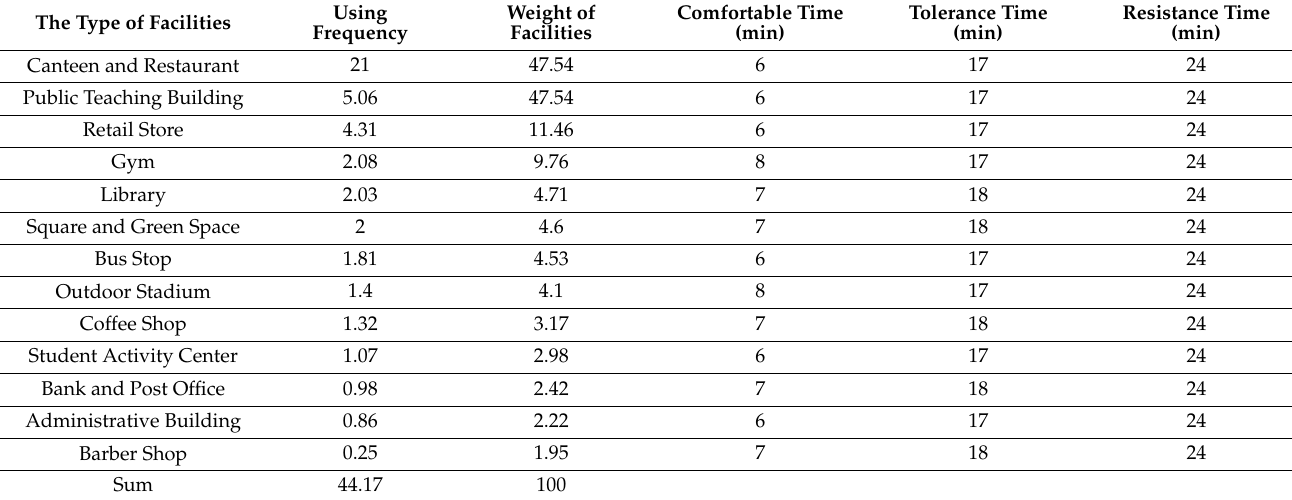
Table 2. The weight and curve of time decay of each